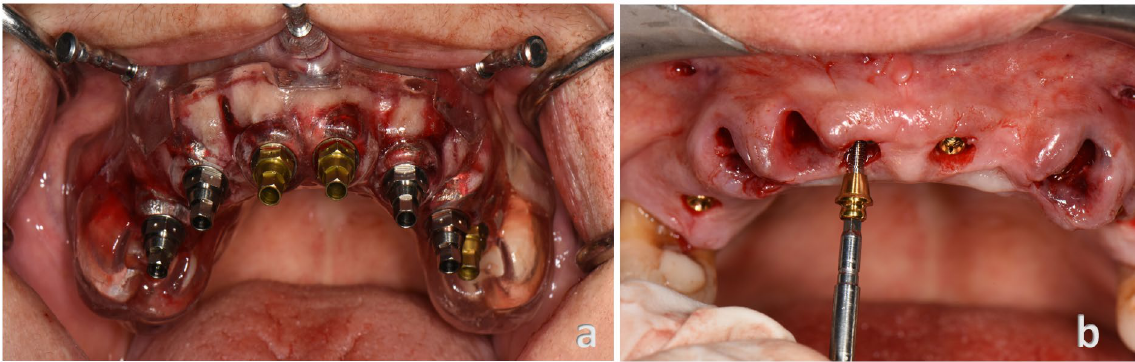
Figure 11. Implant insertion ( a ) and OT-Equator attachments positioning ( b ).